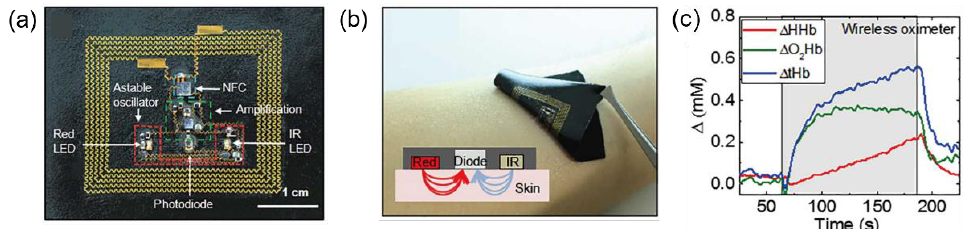
Figure 4. ( a ) Image of the device that includes near-field communication (NFC), amplification, a stable oscillator, two LEDs, and a photodiode on a flexible substrate (black space). ( b ) Photograph of the device used on the forearm. The inset shows the image of the diode receiving light in the reflective mode. ( c ) Measurements obtained by an epidermal device recorded from adjacent regions of the forearm. The gray area shows changes in oxyhemoglobin and deoxyhemoglobin concentrations when vein occlusion for 120 s (ΔtHb = Δ O 2 Hb + Δ HHb). Adapted with permission from [30] AAAS, 2019.